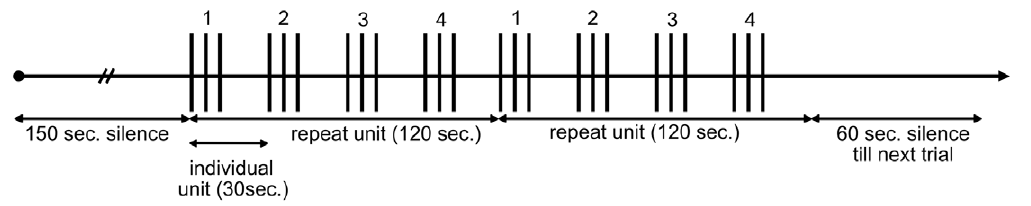
Figure 1. Playback design for fledgling stimulus. Each fledgling stimulus was used with both parents. The order of own and alien stimuli (1, 2, 3, 4) was randomized with the repeat unit.